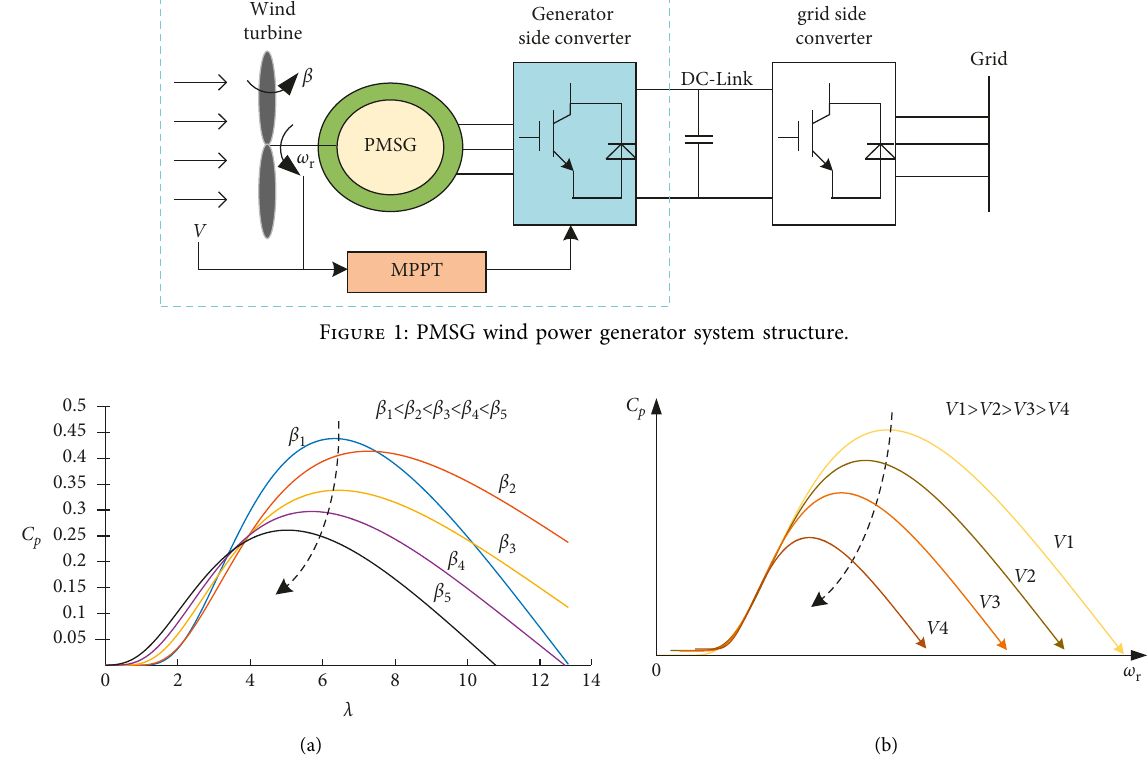
Figure 2: (a) Relationship between C